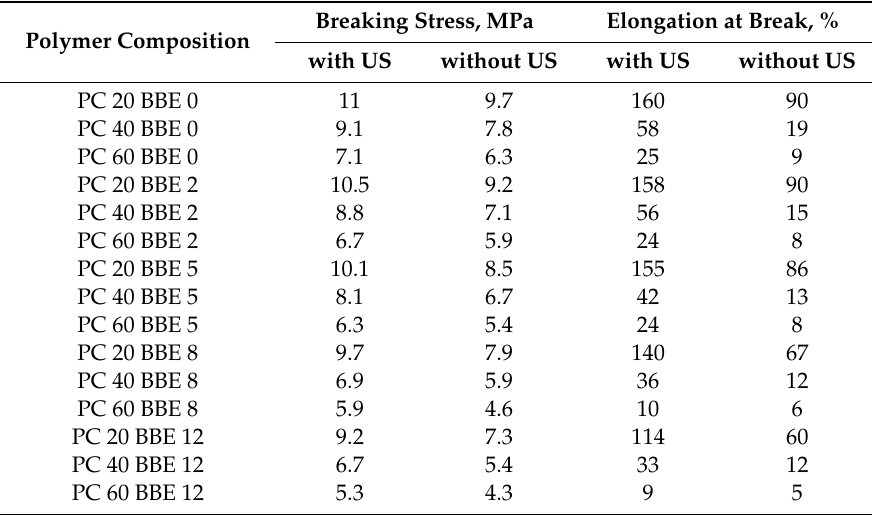
Table 9. Physico-mechanical properties of composite polymeric films (PC) according to the content of birch bark extract (BBE) and the use of ultrasonic treatment (US). Breaking Stress, MPa Elongation at Break, % Polymer Composition with US with